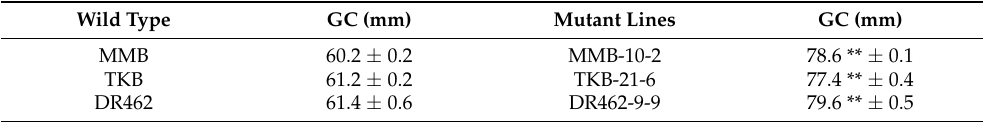
Table 2. GC in partial T 2 mutant lines and wild type.